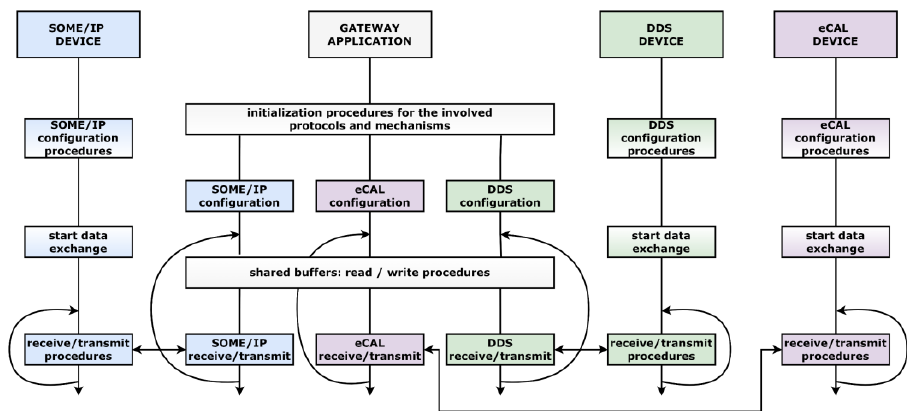
Figure 5. Procedure sequence for all nodes of the architecture.